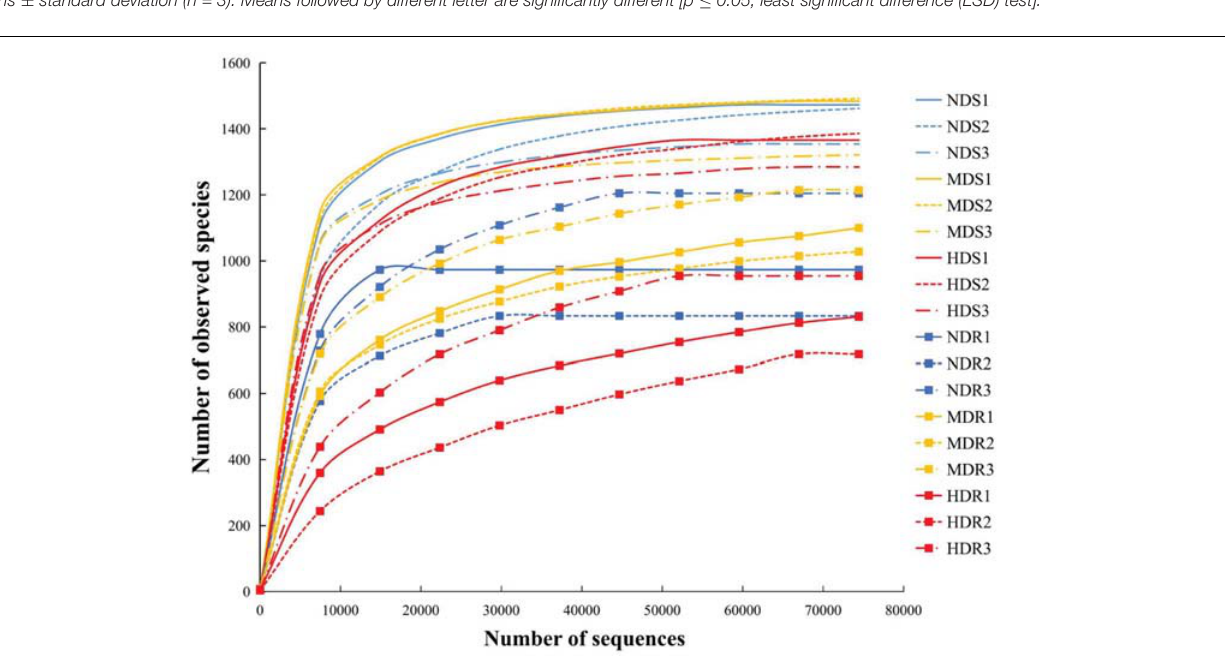
FIGURE 1 | Rarefaction curves showing the relationships between the number of sequences and the number of observed species identified in the soil and root samples of konjac from the non-diseased (NDS and NDR), moderately diseased (MDS and MDR), and highly diseased (HDS and HDR)